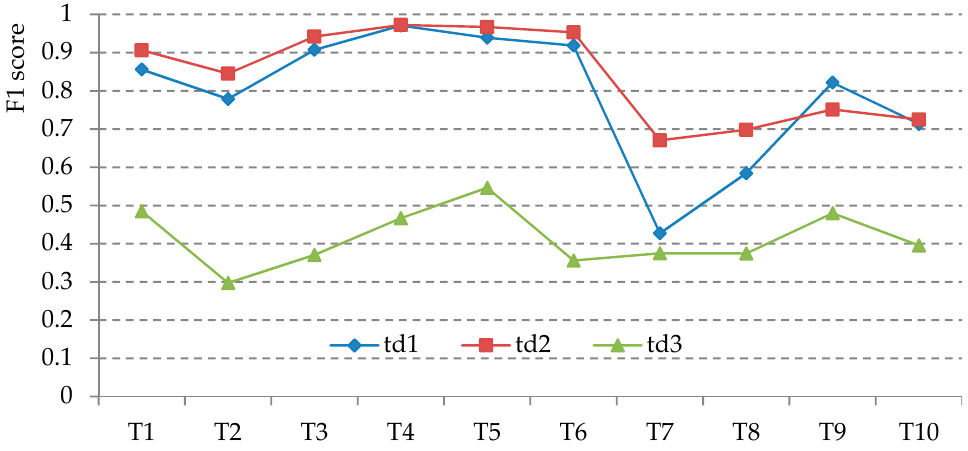
Figure 12. Average F1 scores of 10 test areas for 12 groups of models with different training data as explained in Table 2.